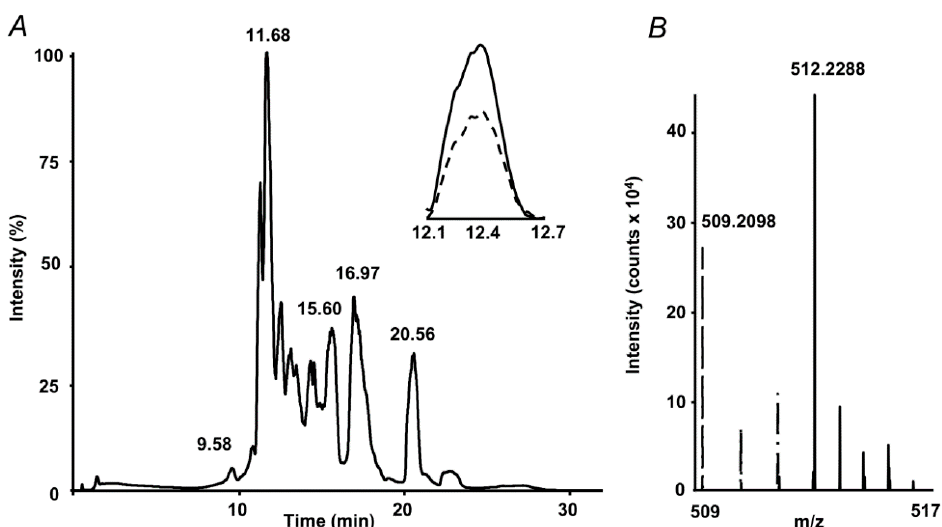
Figure 2. Absolute quantification of methylglyoxal hydroimidazolone 1 (MG-H1) adducts in protein hydrolysates by stable isotope dilution: total ion chromatogram (TIC) with extracted ion chromatograms (XICs) at m / z 509.21 ± 0.03 (dashed) and 512.22 ± 0.03 (solid) corresponding to the [M + H + ] + ions of MG-H1 and spiked MG-H1-d3 internal standard, respectively ( A ), and the corresponding segment of the mass spectrum, representing isotopic patterns of both isotopomers ( B ).